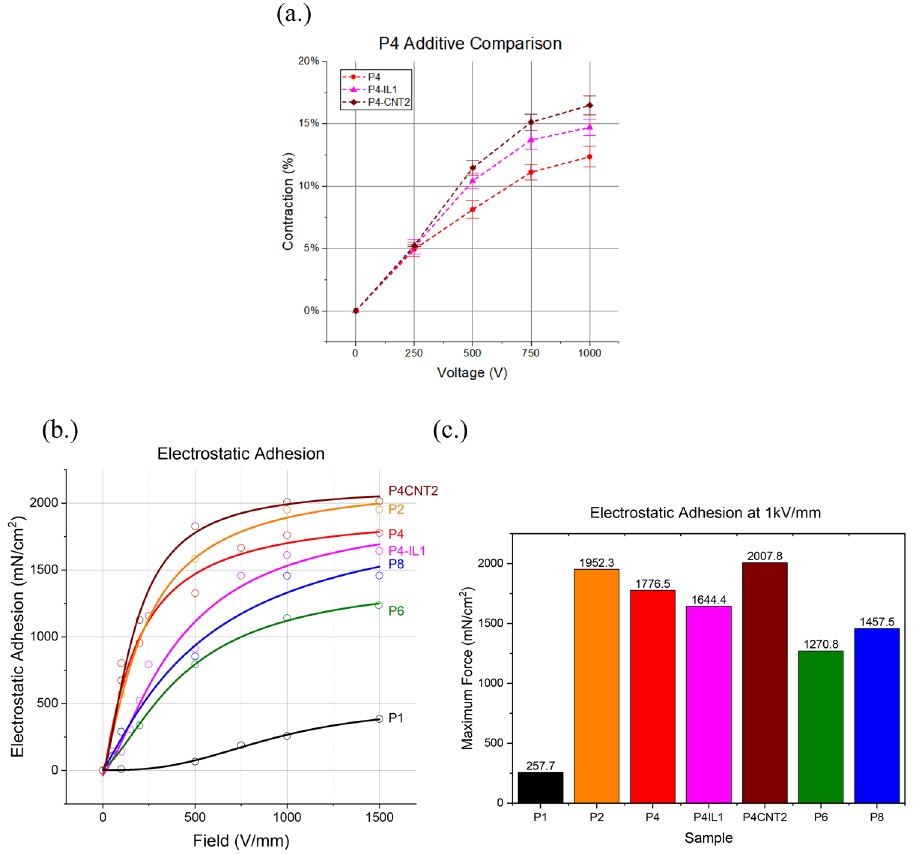
Figure 5. ( a ) Contraction of a mesh actuator for gels with different additive content. ( b ) Electrostatic adhesion force at 1 kV/mm for PVC gels with different filler and plasticizer content. ( c ) Electrostatic adhesion force for varying electric field